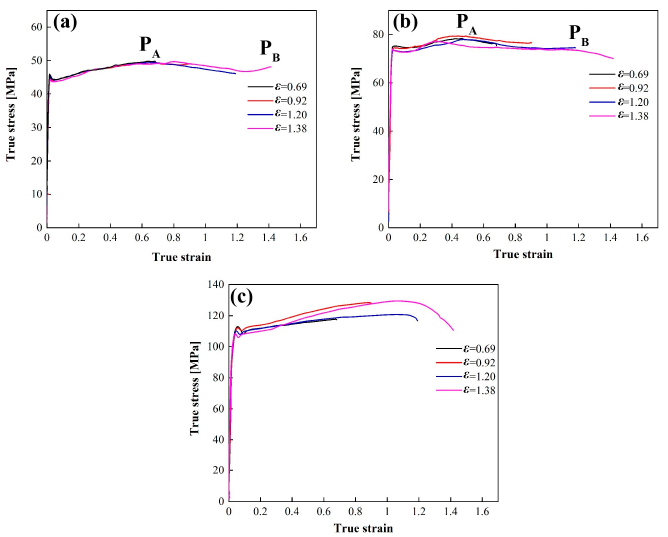
Figure 2. True stress-strain curves at 400 °C, the true strain of 0.69–1.38 and different strain rates of ( a ) 0.01 s − 1 , ( b ) 0.1 s − 1 and ( c ) 1.0 s − 1 .